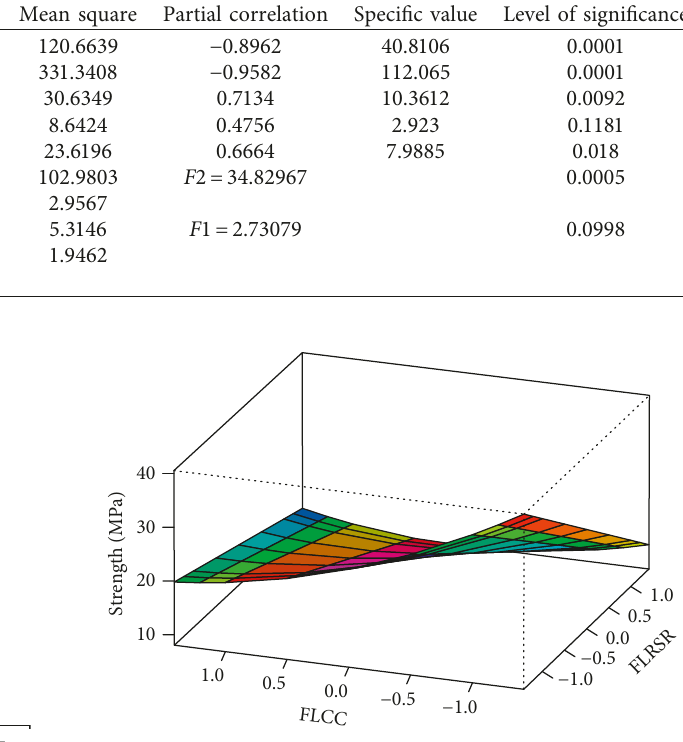
Figure 14: Schematic diagram of 28 d strength.